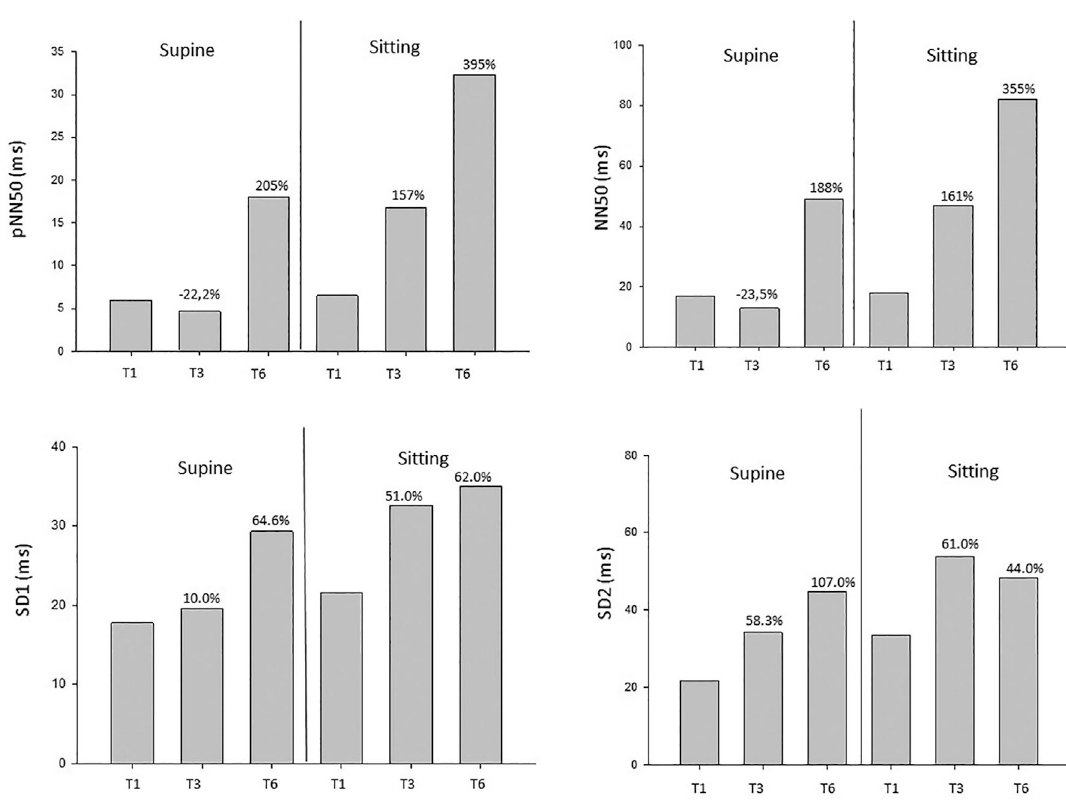
Figure 1 (cont.) - Data on ventilation, ventilation efficiency, and heart rate variability from a woman from a woman with Chagas Cardiopathy throughout the intervention process in the lying and sitting position at baseline (T1), three (T3), and six (T6) months after 24-week combined physical training Legend: IRR: RR intervals; SDNN: Standard deviation of all normal RR intervals; RMSSD: Square root of the mean of the square of the differences between the adjacent normal RR intervals; NN50: Represents the adjacent RR intervals with a difference in duration greater than the 50s; pNN50: Per- centage of adjacent RR intervals with a difference in duration greater than 50s; SD1: Scattering of points perpendicular to the identity line; SD2: Scatter- ing of points along the identity